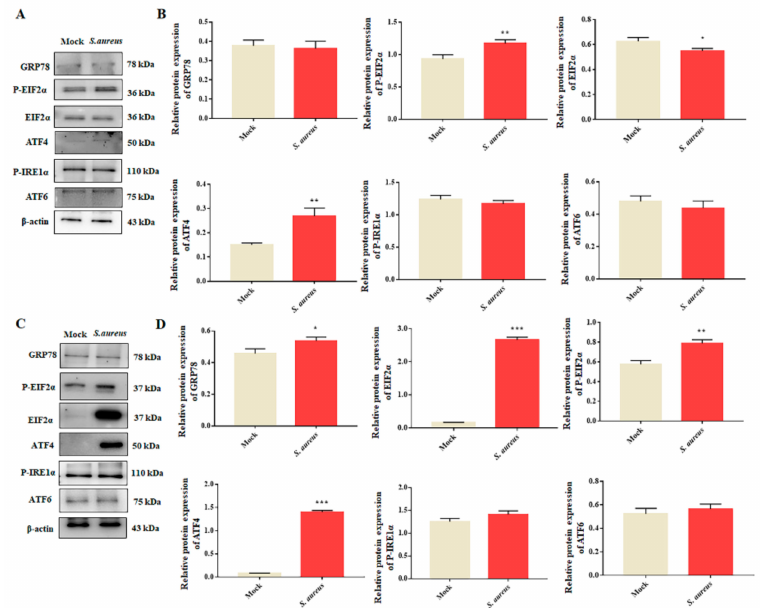
Figure 4. S. aureus infection induces ER stress in gEECs. ( A , B ) Western blot for ER stress-related proteins in whole-cell lysates from gEECs following infection with S. aureus (10 MOI) for 2 h, along with the protein abundance. ( C , D ) The expression of ER stress-related proteins after S. aureus (10 MOI) infection for 4 h, along with the protein abundance. Each experiment was repeated three